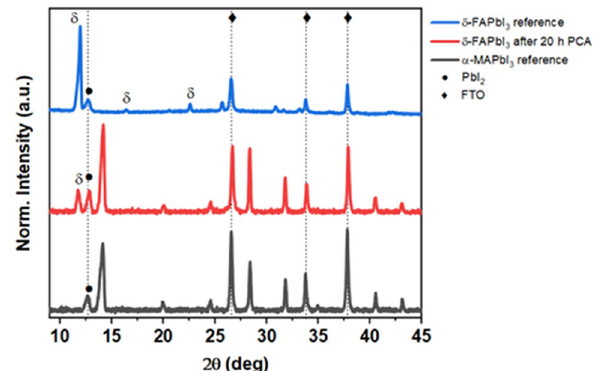
Figure 3. XRD pattern of the investigated δ-FAPbI 3 sample after 20 h PCA (red) compared with reference XRD patterns (blue and black). Phase conversion of the target sample together with residual PbI 2 impurities are